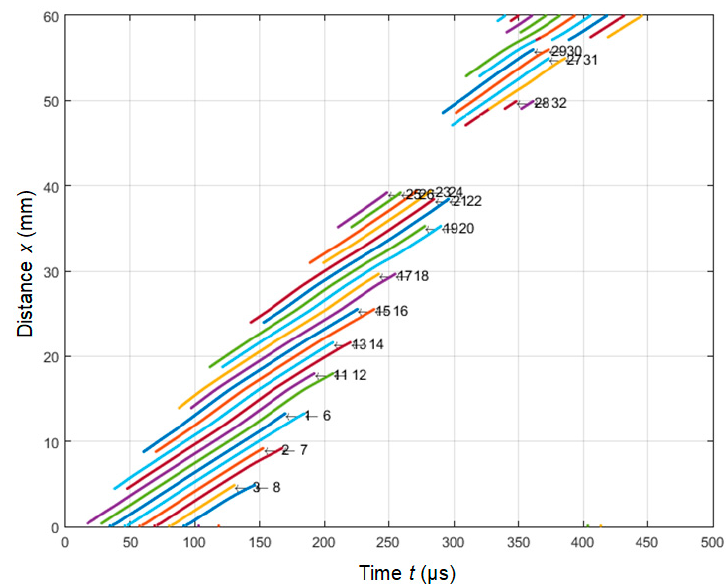
Figure 15. The zero-crossing instants of the normal displacements waveforms along the B-scan line in the mica paper sample with multiple circular non-uniformities.